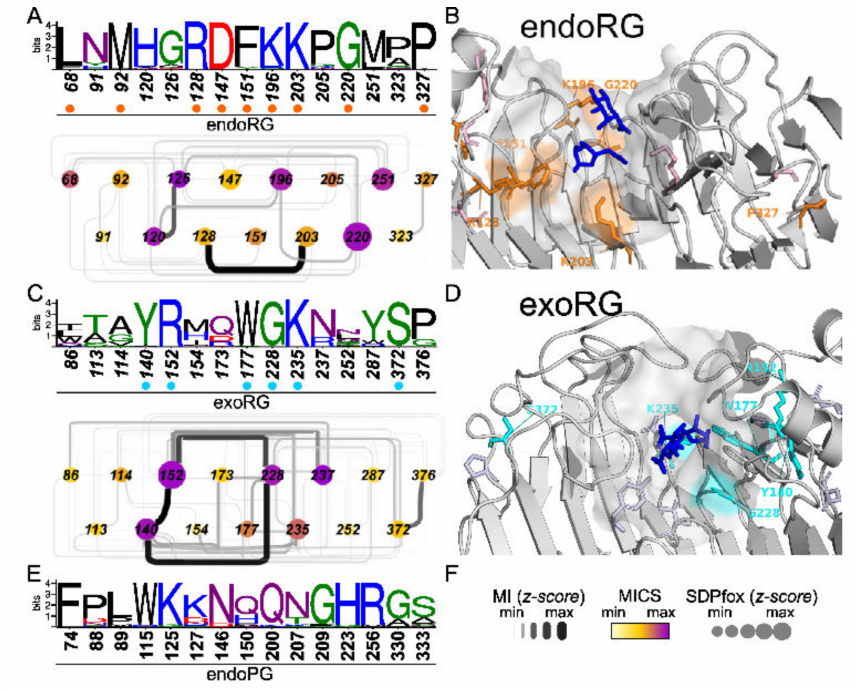
Figure 7. SDP identification in ascomycete endoRG and exoRG classes. ( A , C ) Sequence logos and subSDN of SDPs identified in the analyses endoPG vs. endoRG and endoPG vs. exoRG. Numbers correspond to the reference sequence of each subfamily: endoRG and exoRG. SDN-node colors represent the node’s MICS and the diameter corresponds to the SDPfox z-score. Edges thickness and darkness represent MI z-scores (see panel ( F ) for scales). ( B , D ) The identified SDPs were mapped on endoRG ( B ) and exoRG ( D ) reference structures aligned to 1KCD (galacturonate substrates in blue sticks). Highly conserved residues with physicochemical differences are labelled and indicated in orange (endoRG) or cyan (exoRG). The surface region corresponding to the binding groove is also shown. ( E ) Sequence logo for the identified SDPs in the endoPG set (numbers correspond to